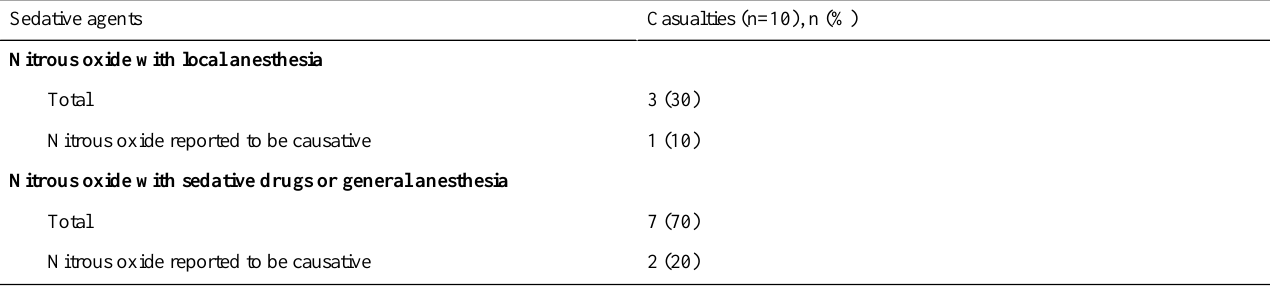
Table 2. Dental practice casualties involving nitrous oxide assigned to the anesthesia, medication, or sedation category from online publications in the United States.